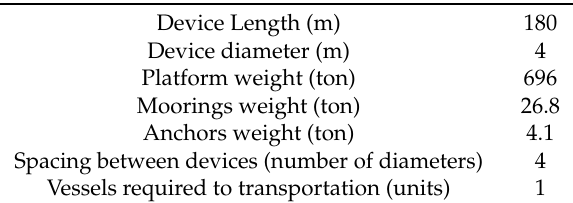
Table 7. Floating offshore wind platform characteristics.